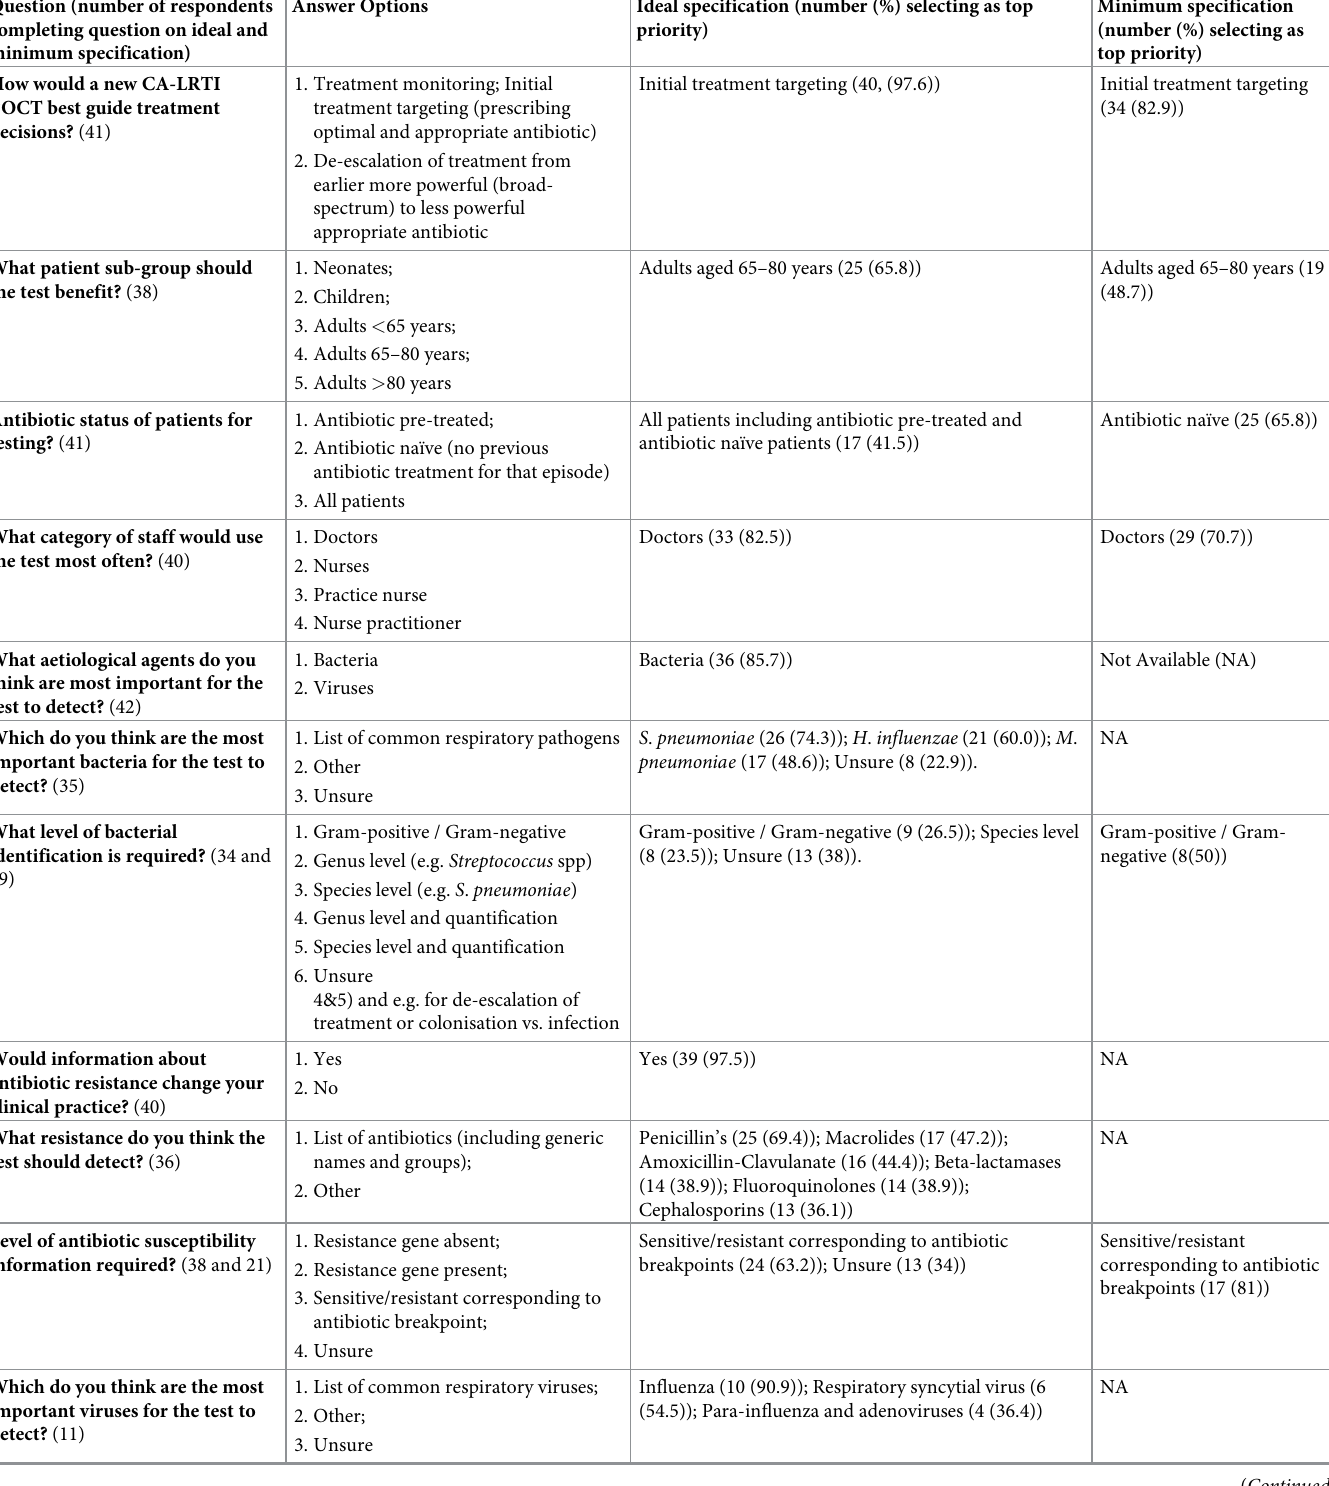
Table 3. The gaps and needs for a priority CA-LRTI POCT as defined by an expert consensus process with primary care clinicians. Question (number of respondents completing question on ideal